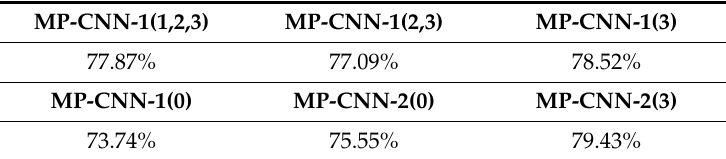
Table 2. Accuracy of the single and combined CNN model.